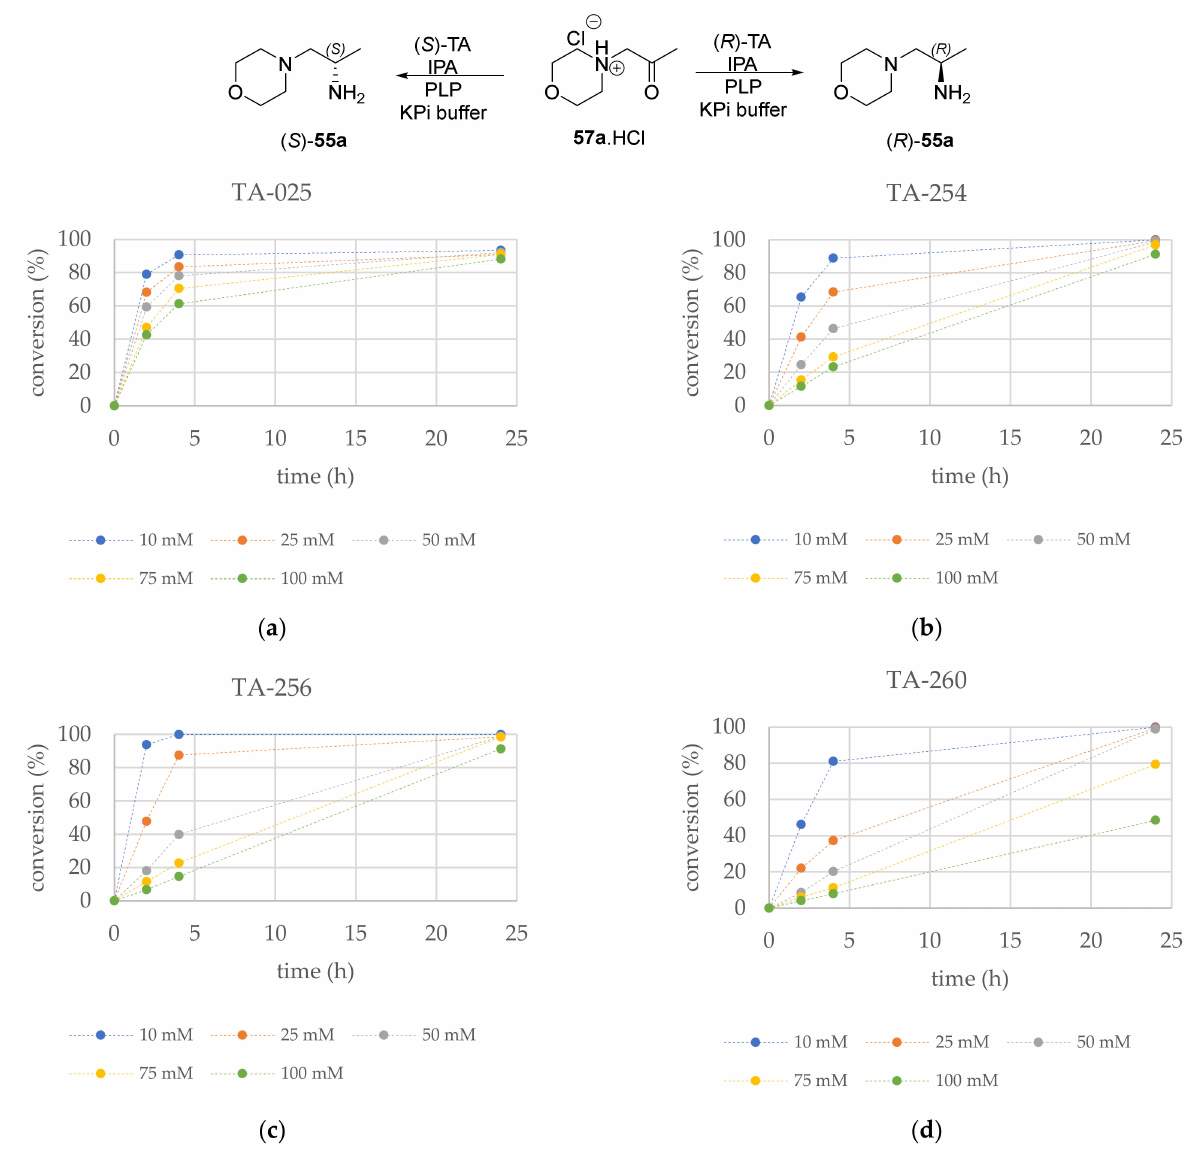
Figure 13. Effect of substrate concentration in transamination of the ketone 57a catalyzed by ( a ) ( R )-TA-025, ( b ) ( S )-TA-254, ( c ) ( S )-TA-256 and ( d ) ( S )-TA-260. Reaction conditions : Total volume: 1 mL, 57a .HCl (10–100 mM), IPA (25 v / v %), TA (2 mg), PLP (1 mM), KPi buffer (100 mM, pH 7.5), at 30 ◦ C for 24